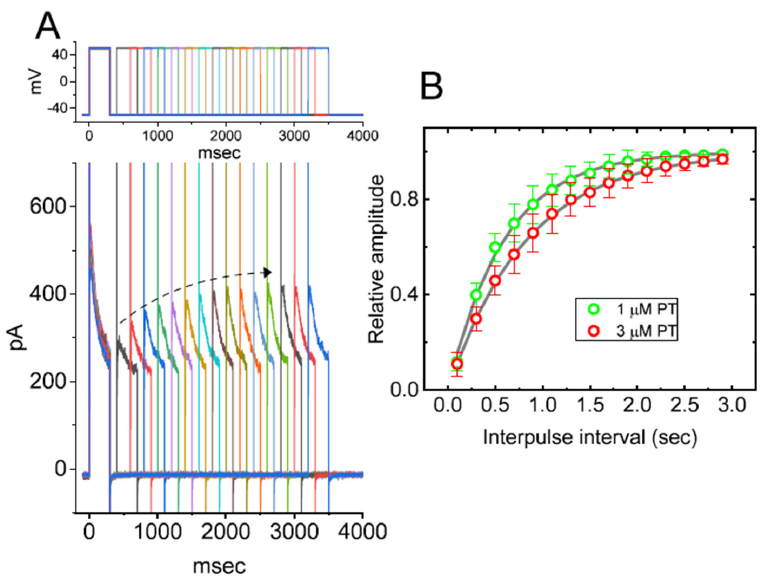
Figure 5. Recovery from I K(DR) block caused by PT-2385. In these recording experiments, we kept cells to be bathed in Ca 2+ -free Tyrode’s solution, while the pipet was filled with K + -containing solution. The examined GH 3 -cell was depolarized from − 50 to +50 mV with a duration of 300 msec, and the different interpulse durations were then delivered. ( A ) Representative I K(DR) traces in the presence of 1 µM or 3 µM PT-2385. The dashed curved arrow in ( A ) indicates an exponential rise as a function of the interpulse interval, while the uppermost part denotes the voltage-clamp protocol applied. ( B ) Time course of recovery from I K(DR) block taken in the presence of 1 µM PT-2385 ( ○ ) or 3 µM PT-2385 ( ○ ). The relative amplitude of I K(DR) was measured as a ratio of the first peak amplitude divided by the second one. The recovery time course (indicated in gray line) during exposure to 1 or 3 µM PT-2385 was noted to display an exponential rise, with a time constant of 0.59 or 0.83 s, respectively. Each point is the mean ± SEM ( n = 7 for each point).